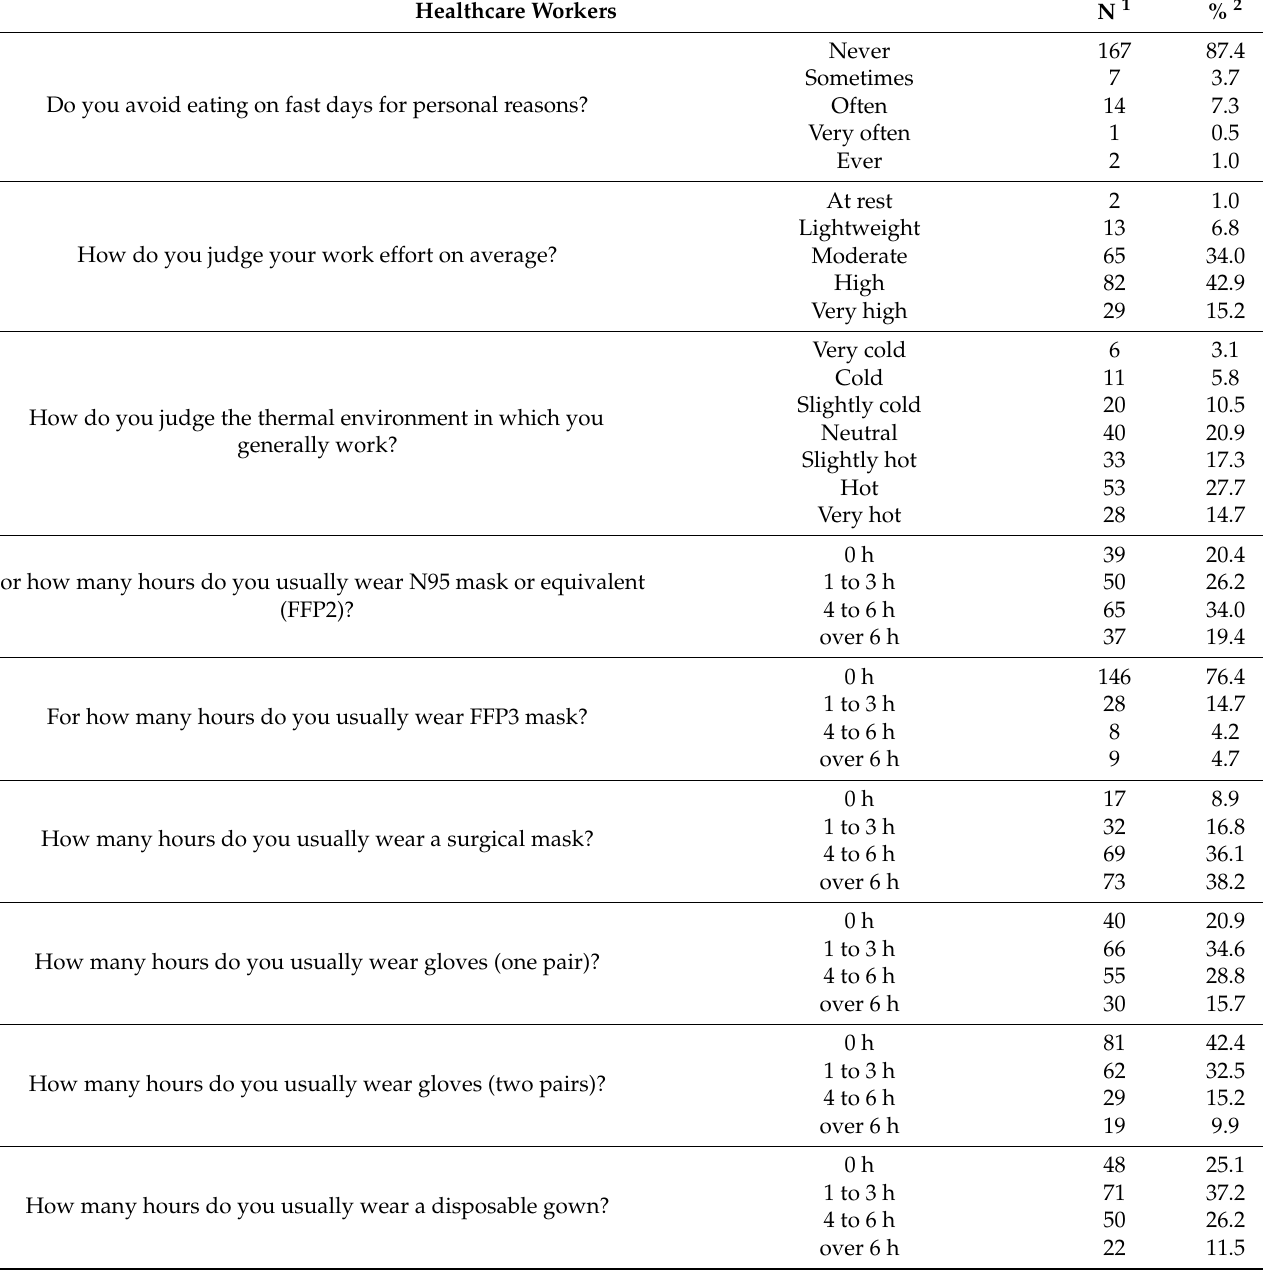
Table 1. Results of the questionnaire submitted to healthcare